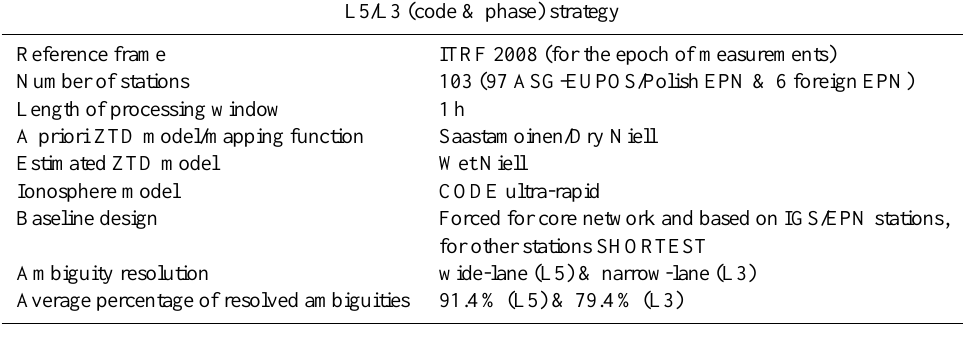
Table 3. Summary of basic information on the NRT GPS data processing at Institute of Geodesy and Geoinformatics in Wroclaw.